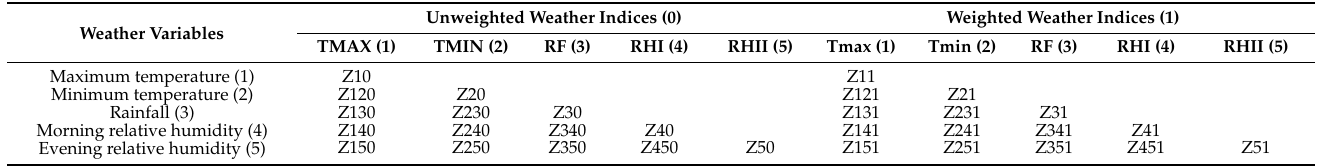
Table 2. Weather-derived indices used in models using composite weather variables.